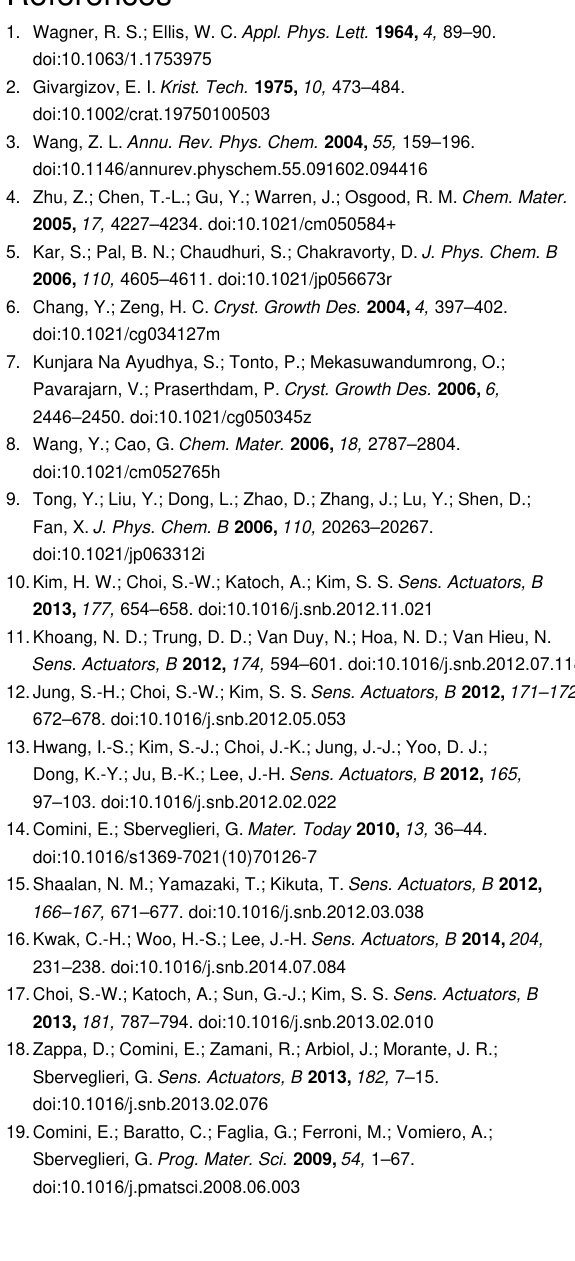
Figure 11: Response of two sensors based on sol–gel technology and on an individual nanowire (NW) as a function of sensor temperature.